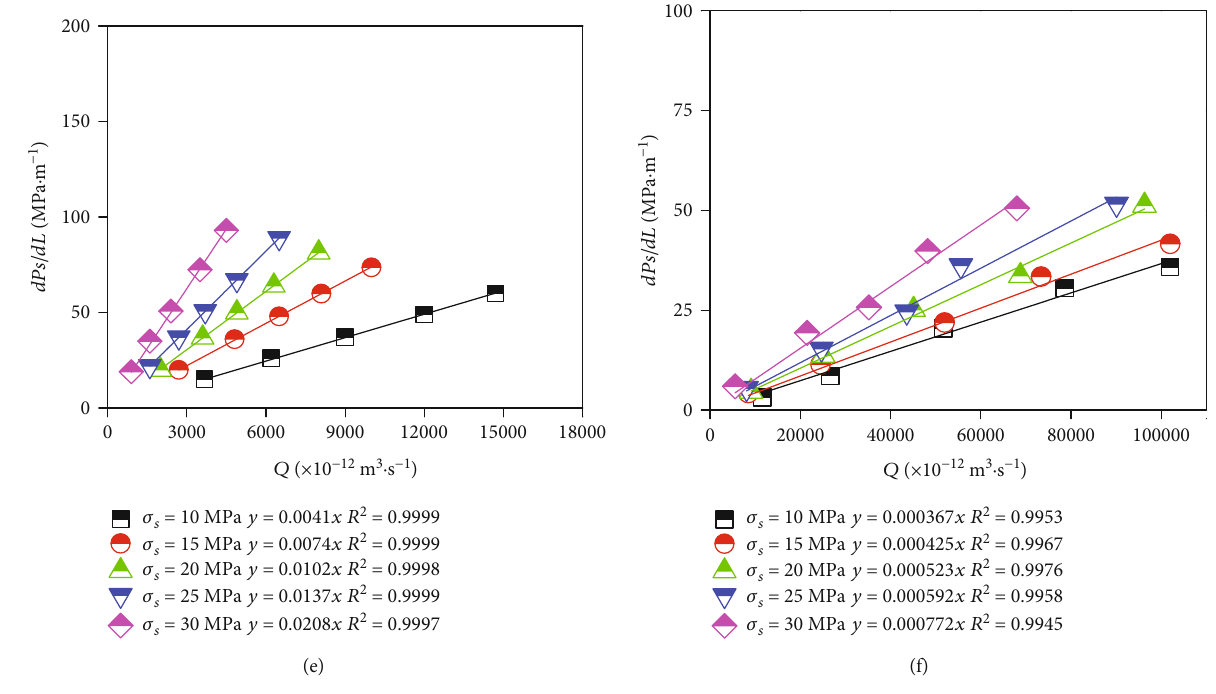
Figure 3: Relationship between volume velocity and pressure gradient. Table 1: Equivalent permeability coe ffi cient of red sandstone specimens at di ff erent temperatures and con fi ning pressures ( × 10 -18 m 2 ).